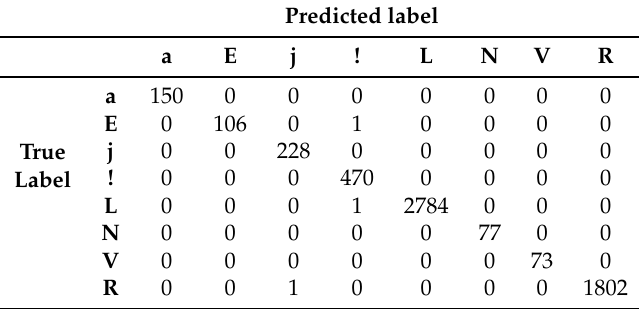
Table 9. Confusion matrix obtained by the best solution of experiment 2.